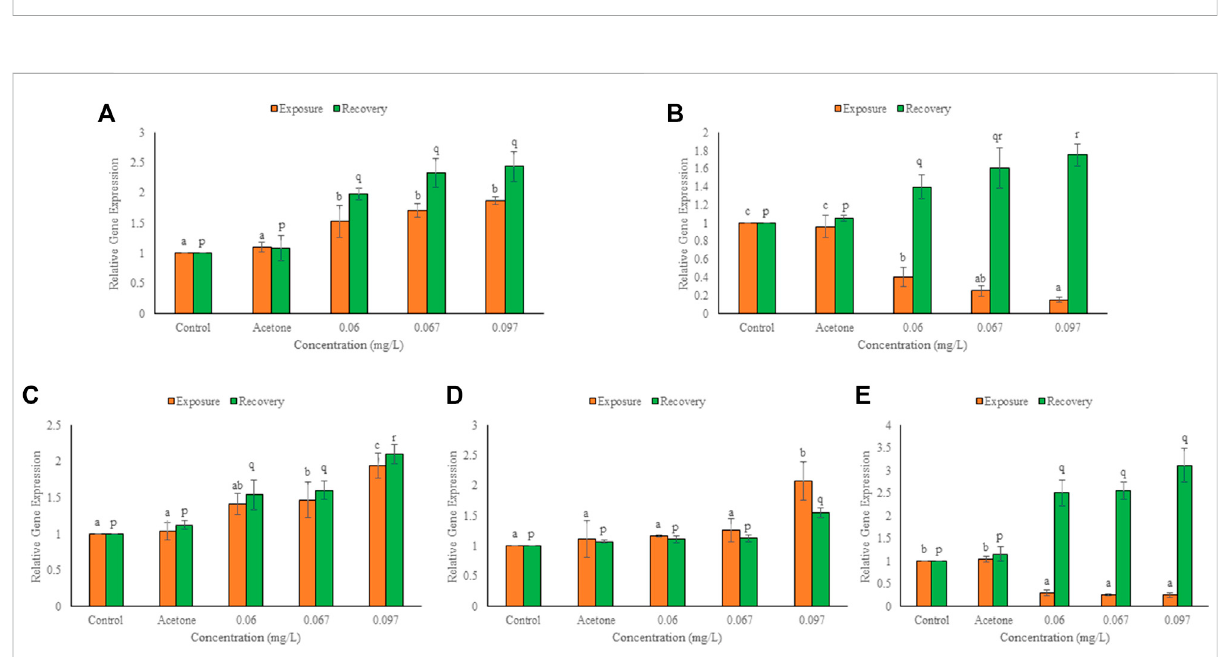
FIGURE 4 Expression of hsp47 (A) , hsp60 (B) , hsp70 (C) , hsc71 (D) , hsp90 (E) , in the hatchlings of L. rohita after 96 h and 10 days post exposure to TCS. Values are, mean ± SD, n = 3, different alphabets represent signi fi cant ( p ≤ 0.01) difference within the treatments after 96 h (a-c) and after 10 days of recovery period